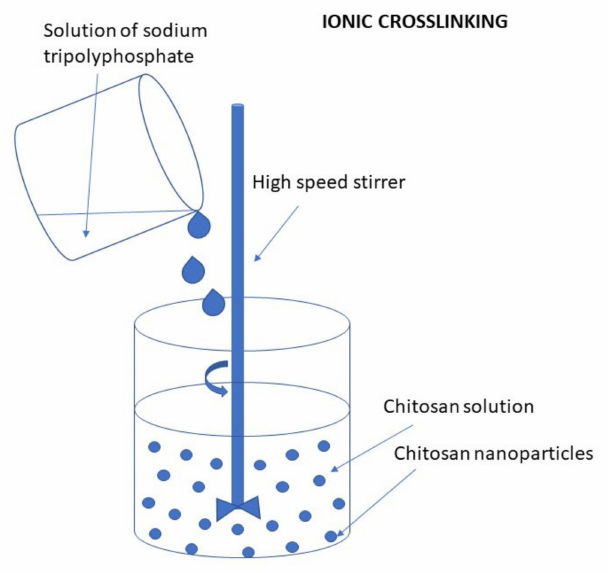
Figure 3. Scheme illustrating preparation of CS NPs by ionic crosslinking with TPP. Sang et al. [71] used the ionotropic gelation method to prepare CS NPs using polyphos- phate crosslinking agents, namely TPP, phytic acid (PA), and sodium hexametaphosphate (SHMP). The encapsulation efficiency of myricetin (MYR) in the CS NPs crosslinked by PA and SHMP (67.3 ± 0.4% and 62.2 ± 0.2%, respectively) was significantly higher than that in the CS NPs crosslinked by TPP (47.7 ± 0.1%) ( p < 0.05); their drug release rate (43.7 ± 5.1% and 44.0 ± 3.7%, respectively) was also significantly slower than that of MYR-CS NPs crosslinked by TPP (103.4 ± 4.0%) ( p < 0.05). Furthermore, a strong mucoad- hesiveness of the CS NPs crosslinked by PA was shown by a fast increase in the turbidity value and a sharp decrease in the zeta potential in the mucin solution